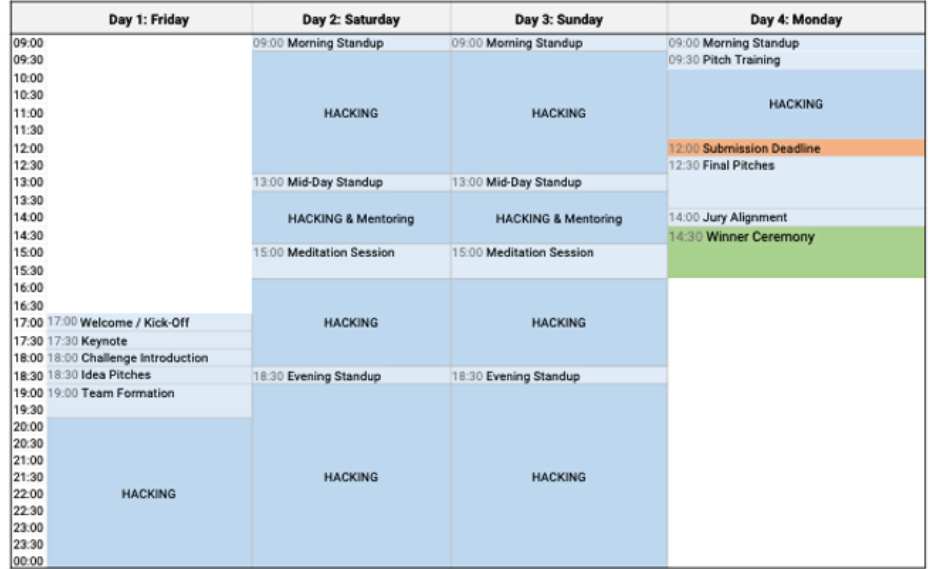
Figure 1. Activities and schedule of a 4-day online